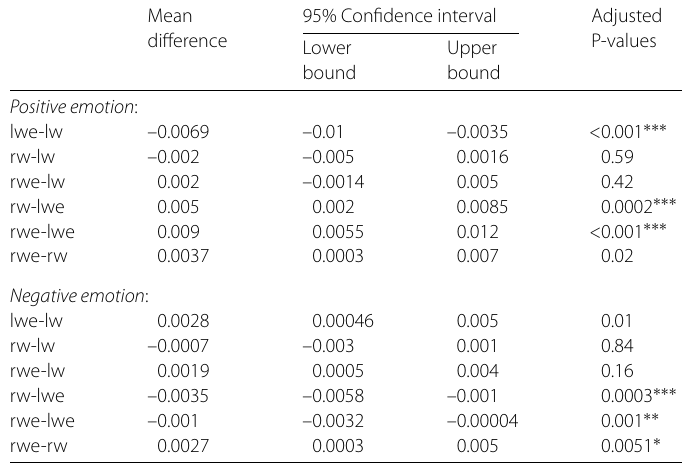
Table A6 Multi-group mean comparisons of positive and negative emotions in 25% sample size data using Tukey’s HSD test Mean 95% Confidence interval Adjusted difference P-valuesLower Upper bound bound Positiveemotion : lwe-lw